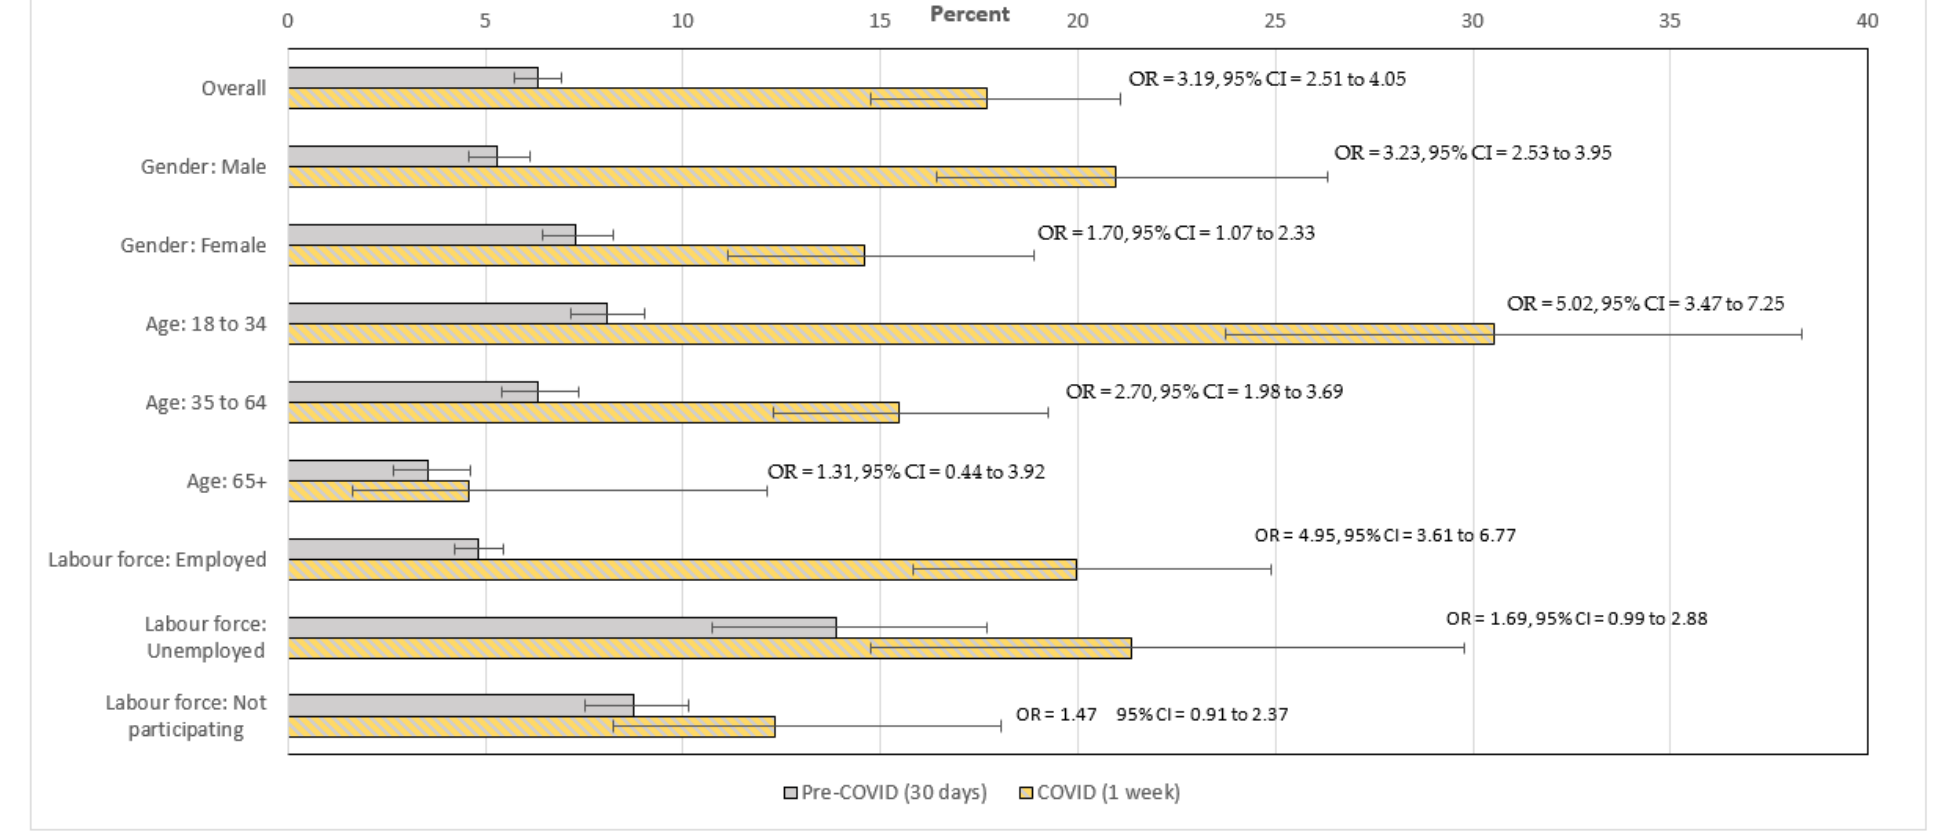
Figure 1. Weighted prevalence estimates of psychological distress (and standard errors) from the K6, comparing the 2019 wave of the HILDA Survey and the TTPN survey (wave 13), with odds ratios (and 95% confidence intervals) within each subgroup. The pre-COVID measure is the reference category for all analyses.